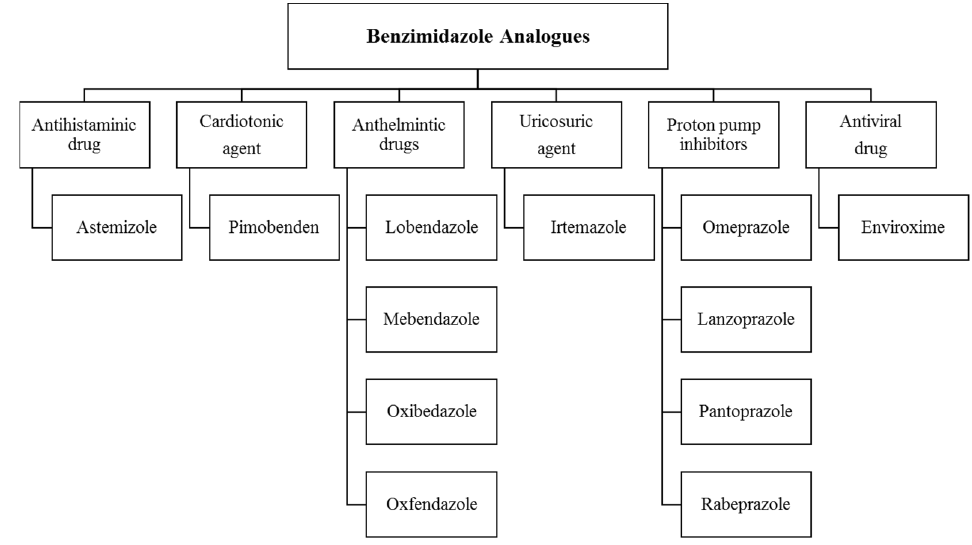
Figure 3. Clinically approved drugs with a benzimidazole nucleus.